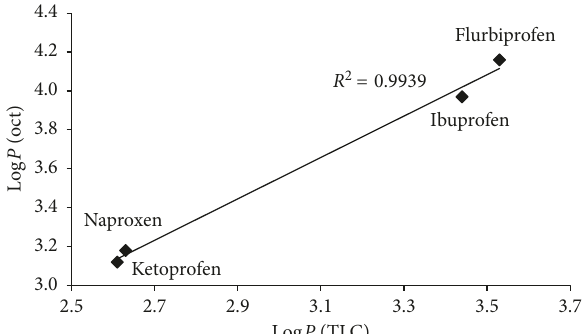
Figure 2: The correlation between the Log P determined with the n -octanol/water (Log P (oct)) [14] and the HPTLC (Log P (TLC)) methods of the analyzed Table 4: The experimental values of Log P and the theoretical values of Log P [14] of the investigated compounds. Compound